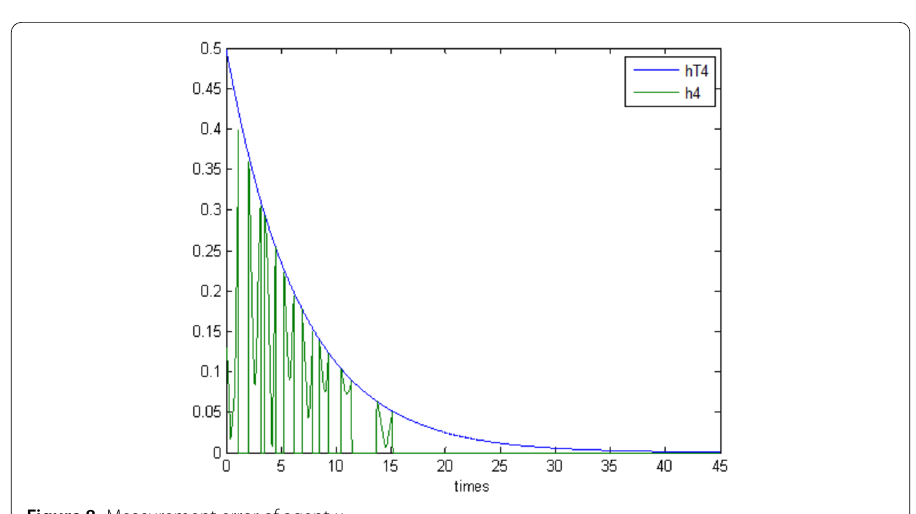
Figure 8 Measurement error of agent x 4